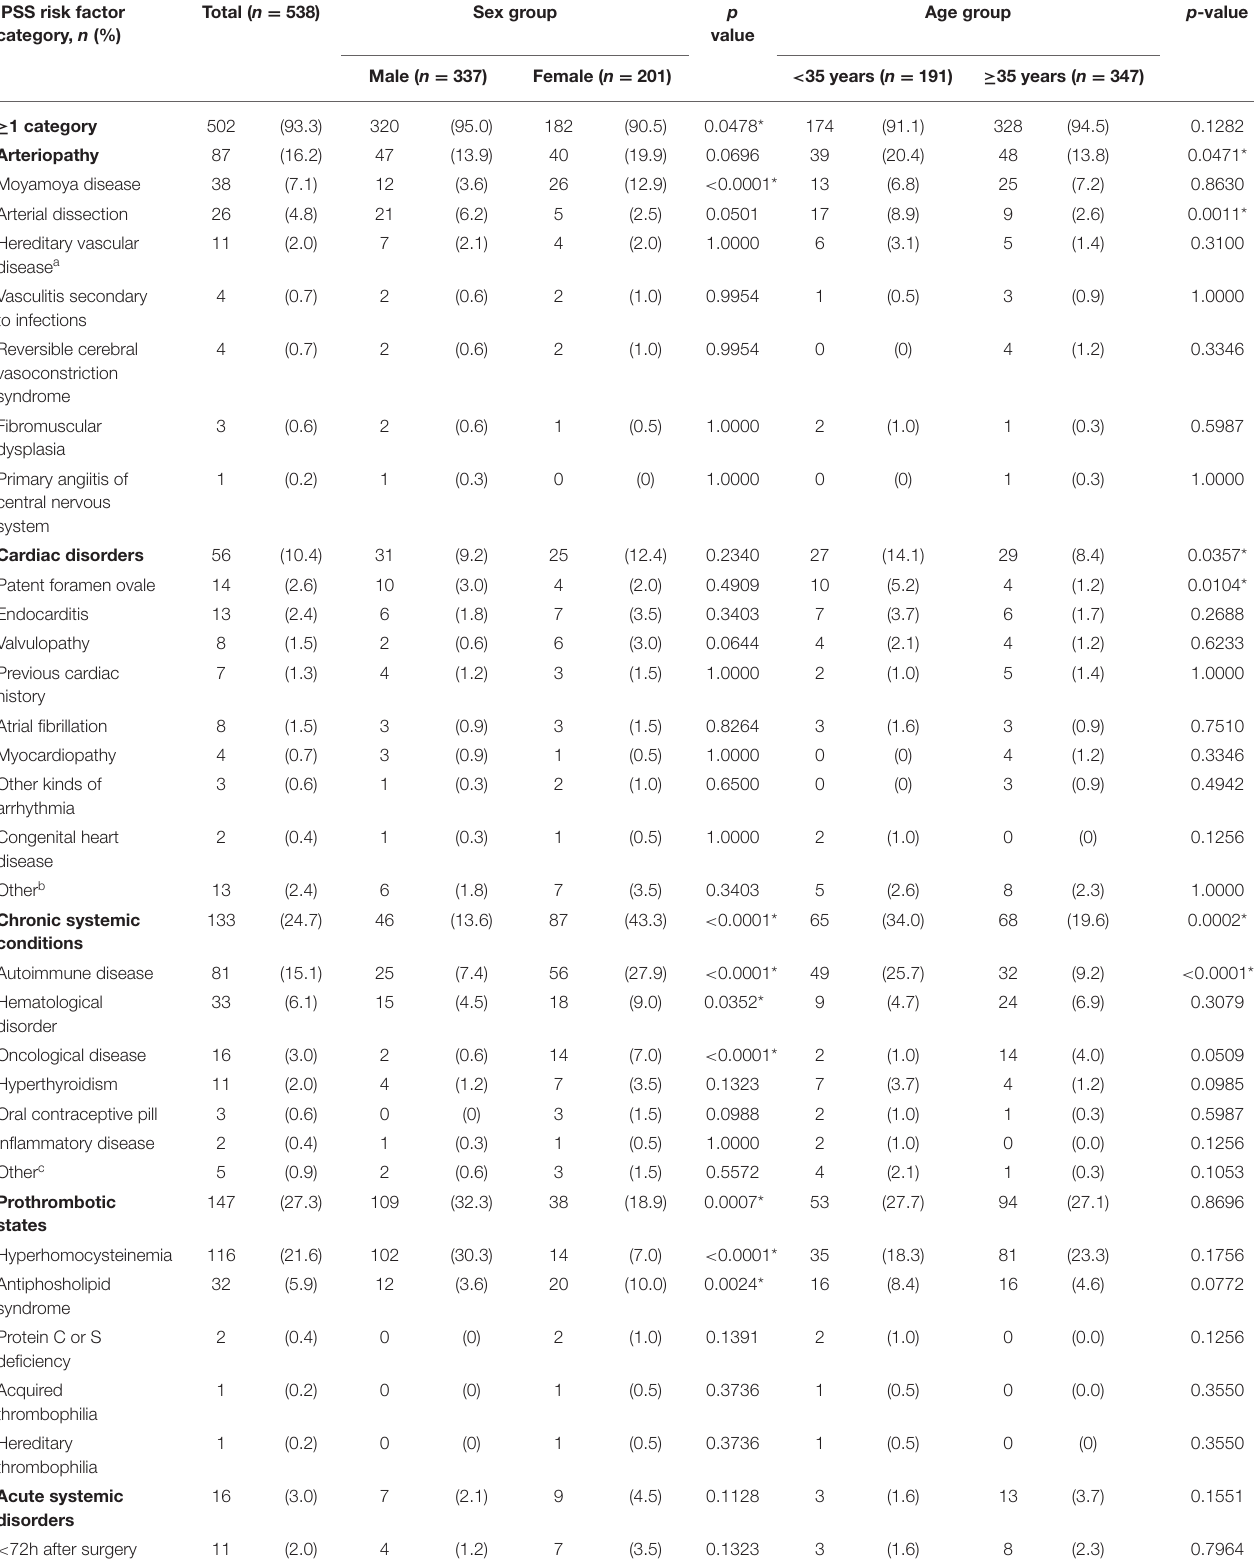
TABLE 2 | The IPSS risk factor